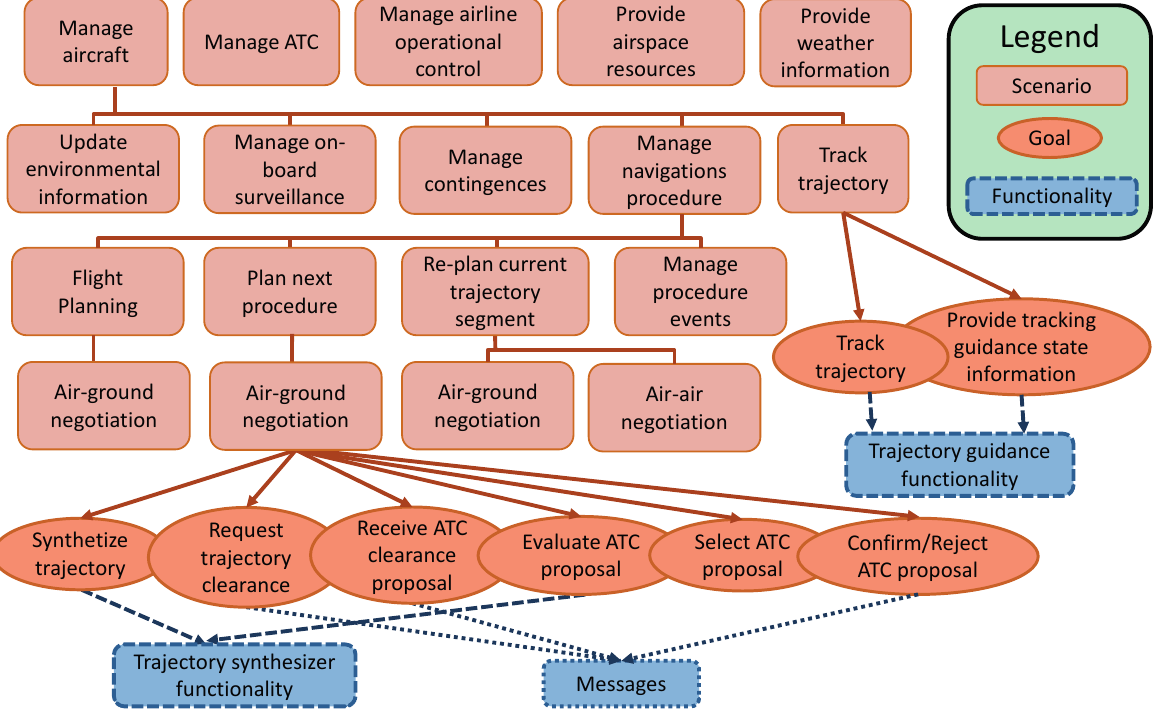
Figure 2. System Specification from aircraft scenarios: goals and functionalities identified from “trajectory guidance” and “air-ground negotiation”